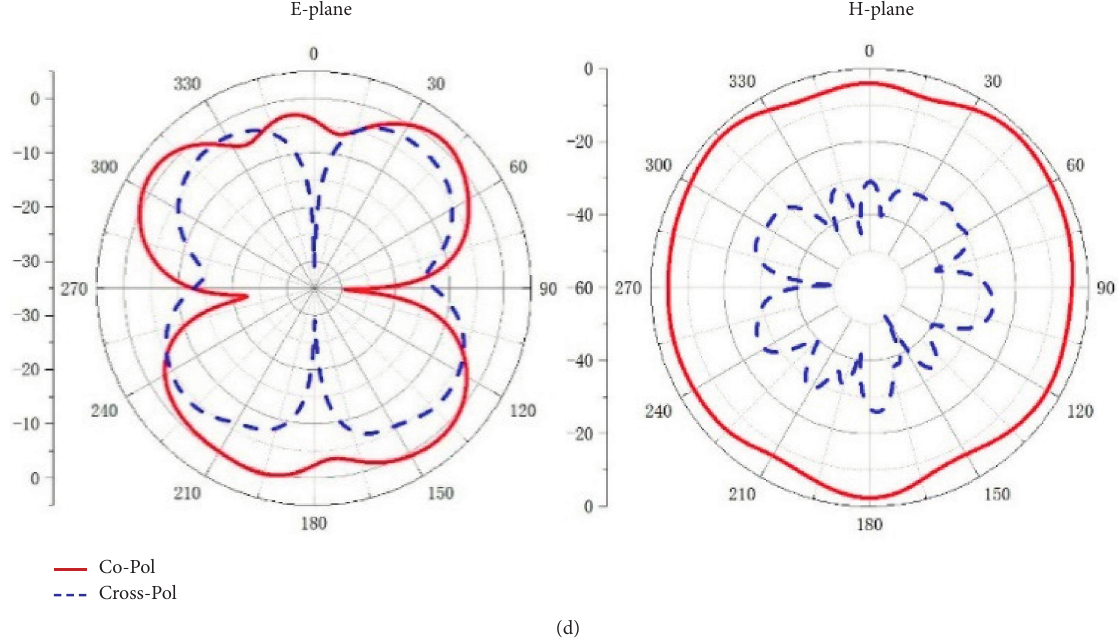
Figure 11: E- and H-plane radiation patterns at (a) 1.6 GHz, (b) 2.35 GHz, (c) 3.8GHz, and (d) 5.85GHz.